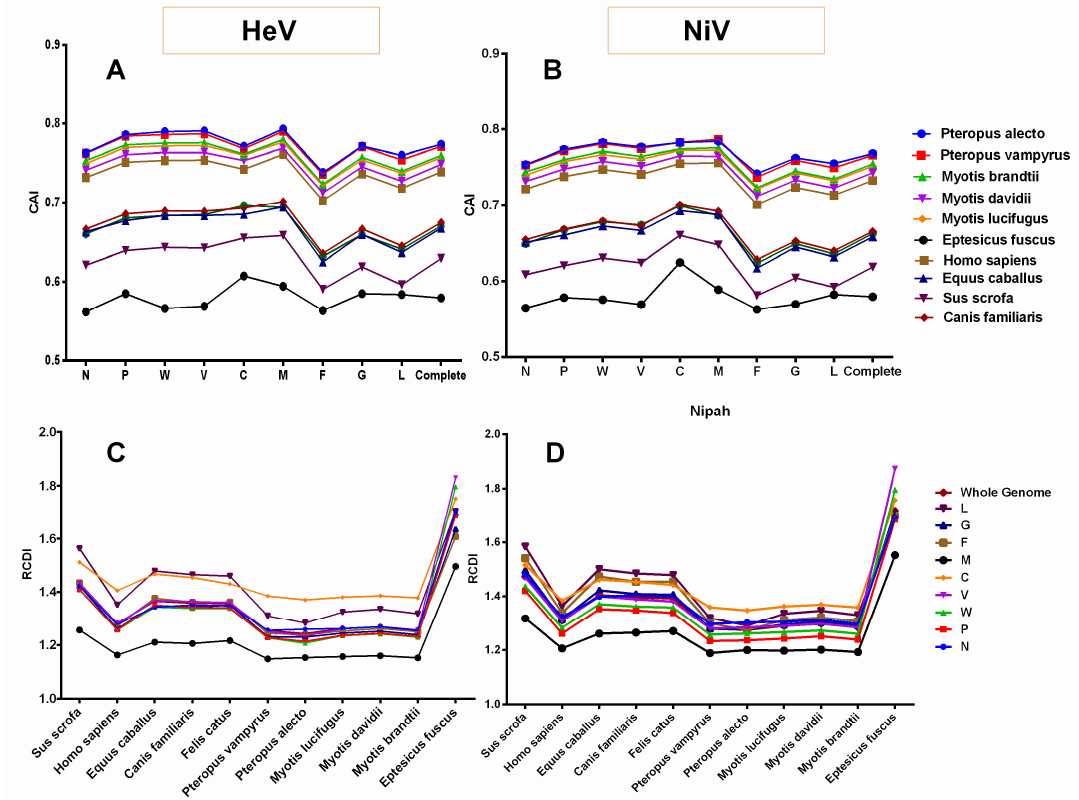
Figure 6. The Codon adaptation index (CAI) and relative codon deoptimization index (RCDI) analyses of HeV ( A , C ) and NiV ( B , D ) coding sequences in relation to different host species.